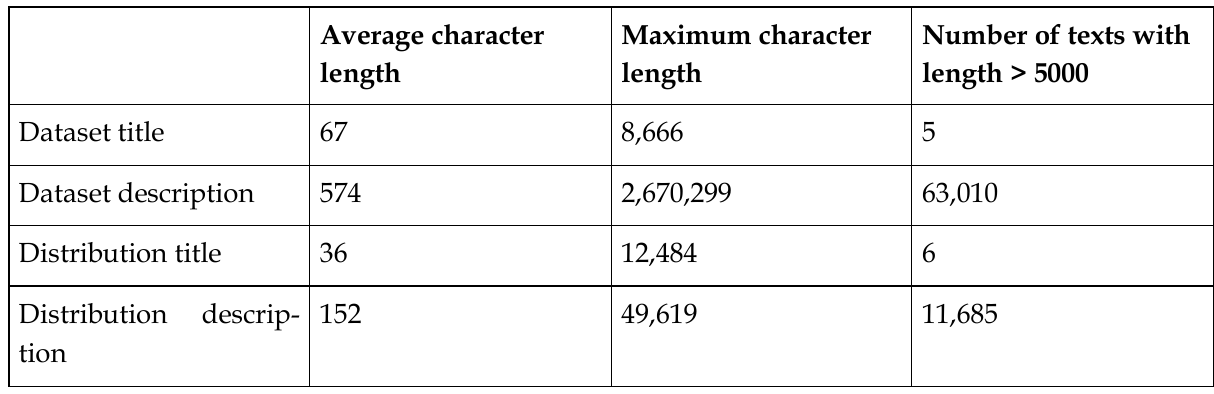
Table 3: Average character length of title and description including maximum value and the number of metadata which exceeds eTranslations character